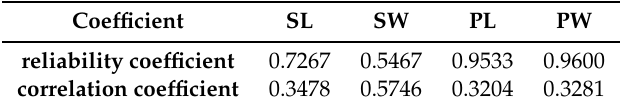
Table 2. The reliability coefficient and correlation coefficient of four attributes.